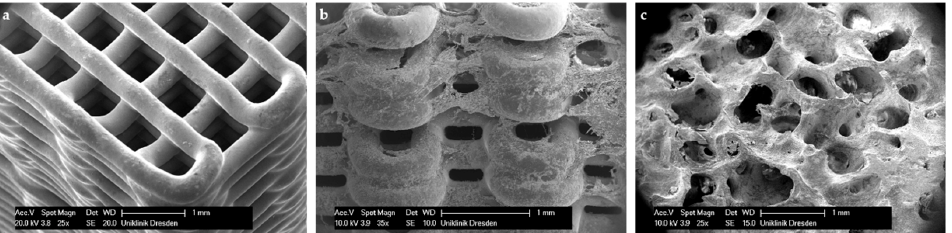
Figure 5. SEM imaging of CPC scaffold D non-colonized ( a ) and after 28 days ( b ) in comparison to BioOss ® ( c ).